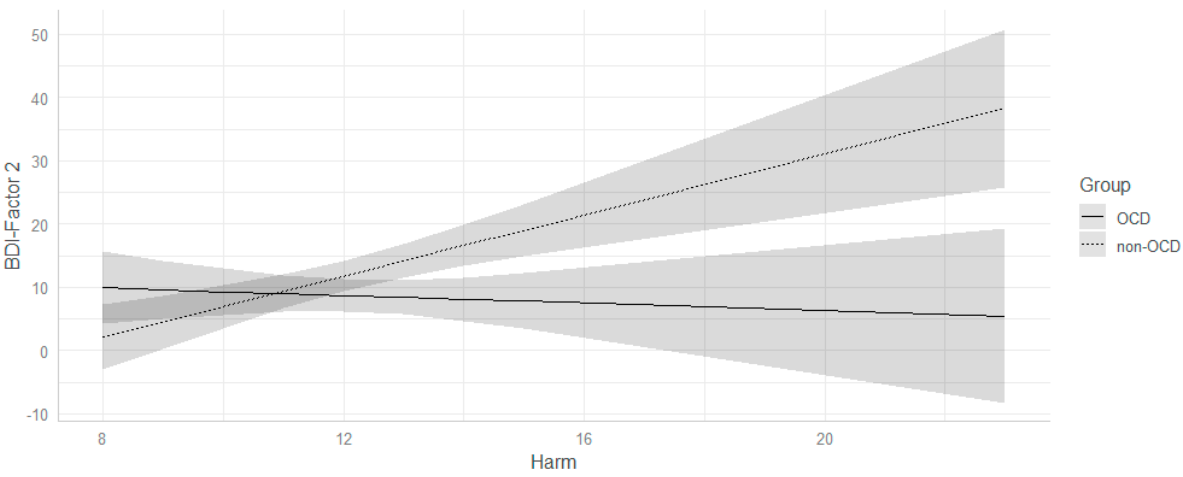
Figure 3. Harm × group interaction on factor 2 scores of BDI. Grey areas represent confidence intervals. BDI= Beck Depression Inventory.